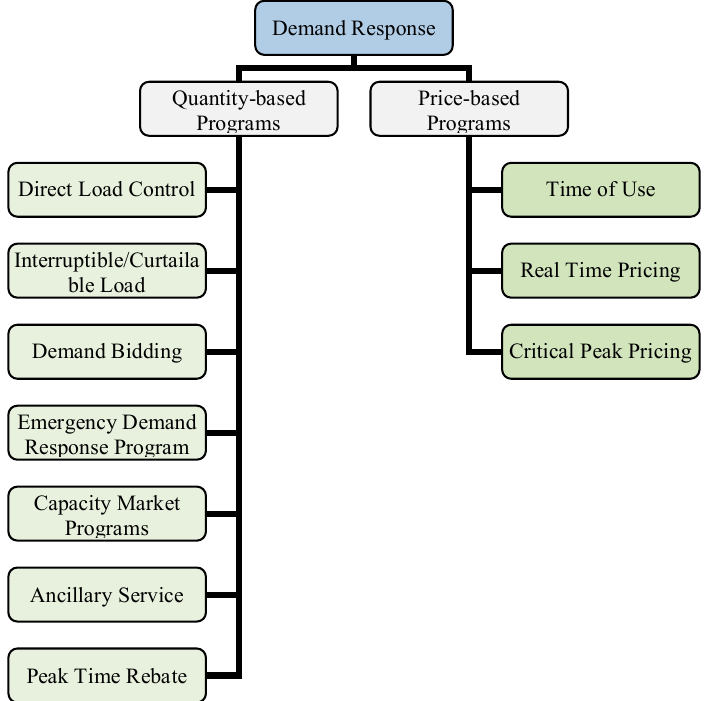
Figure 4. Classification of demand response programs [41].